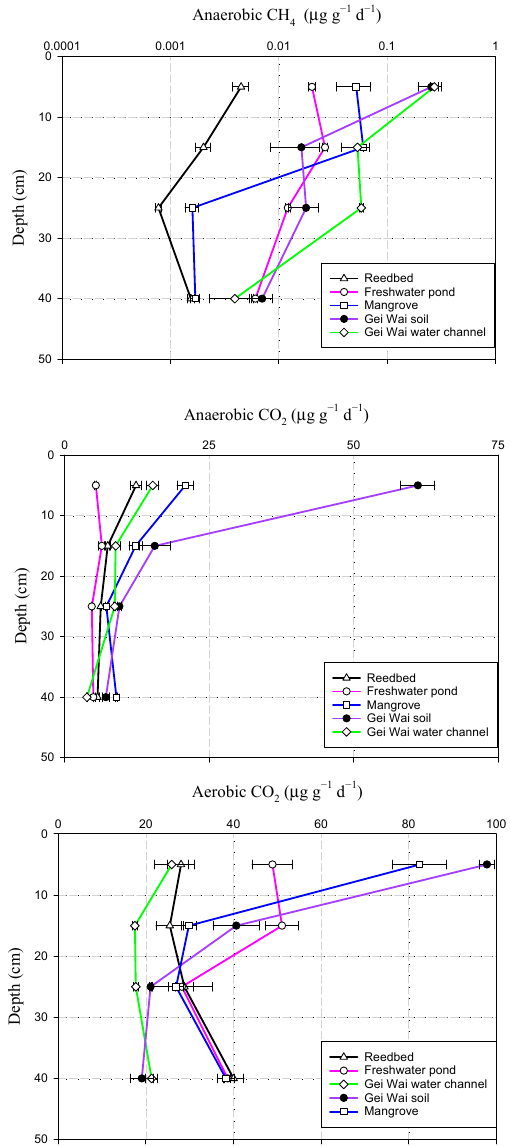
Figure 3. Depth profiles of anaerobic CH 4 , anaerobic CO 2 , and aerobic CO 2 production potentials for the five land use types. Data are means ± standard deviation.